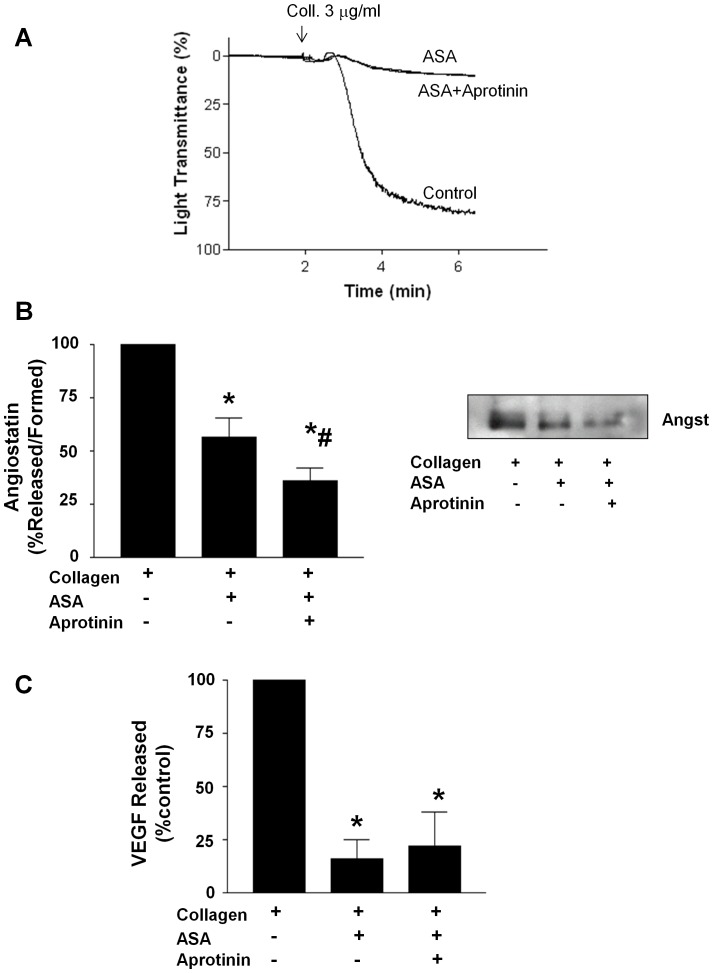
ASA suppresses platelet angiostatin release but not generation.(A) Represenative traces demonstrating the effects of ASA (100 µM) and aprotinin (30 µM) on platelet aggregation. (B) Summary densitometry data and represenative immunoblot demonstrating the effects of ASA and aprotinin on platelet angiostatin generation/release. (C) Summary data demonstrating the effects of ASA and aprotinin on platelet VEGF release. N = 4. *, P<0.05 vs. control. Angst – Angiostatin.